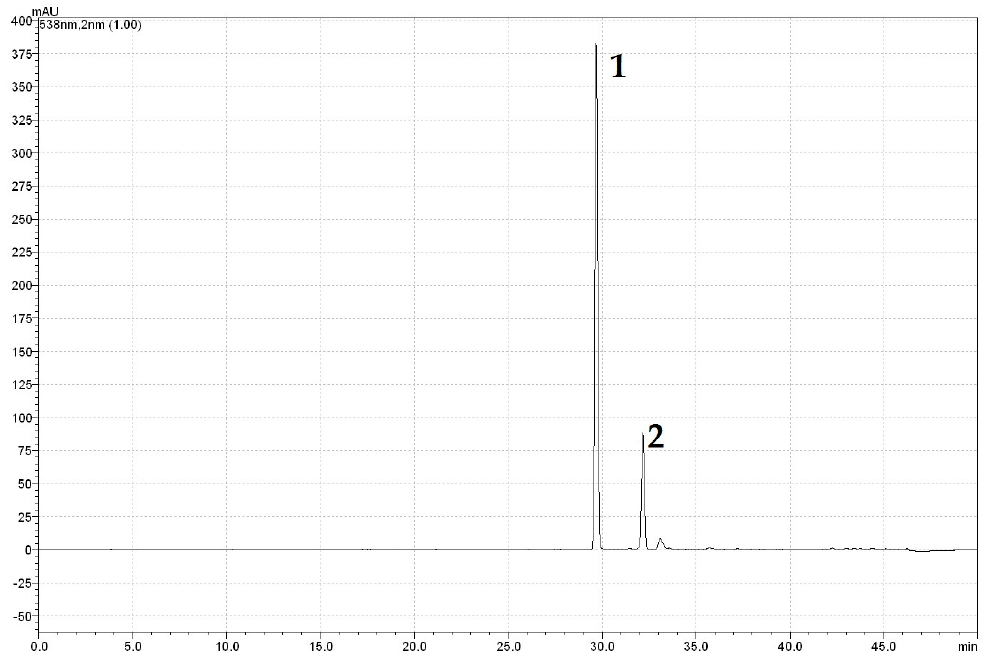
Figure A2. HPLC chromatogram of betalains at a wavelength of 538 nm: 1—betanin, 2—isobetanin.